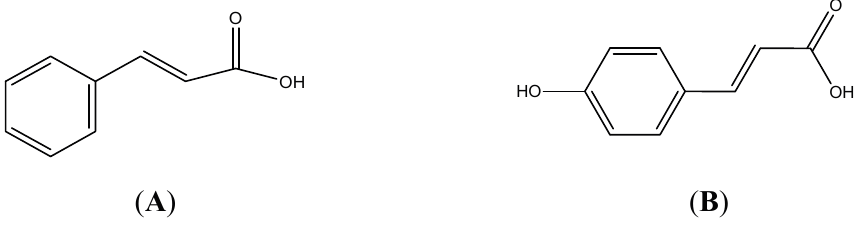
Figure 2. Structures of cinnamic acid ( A ) as the major component and para -hydroxycinnamic acid ( B ) as the minor components presented in Subfraction